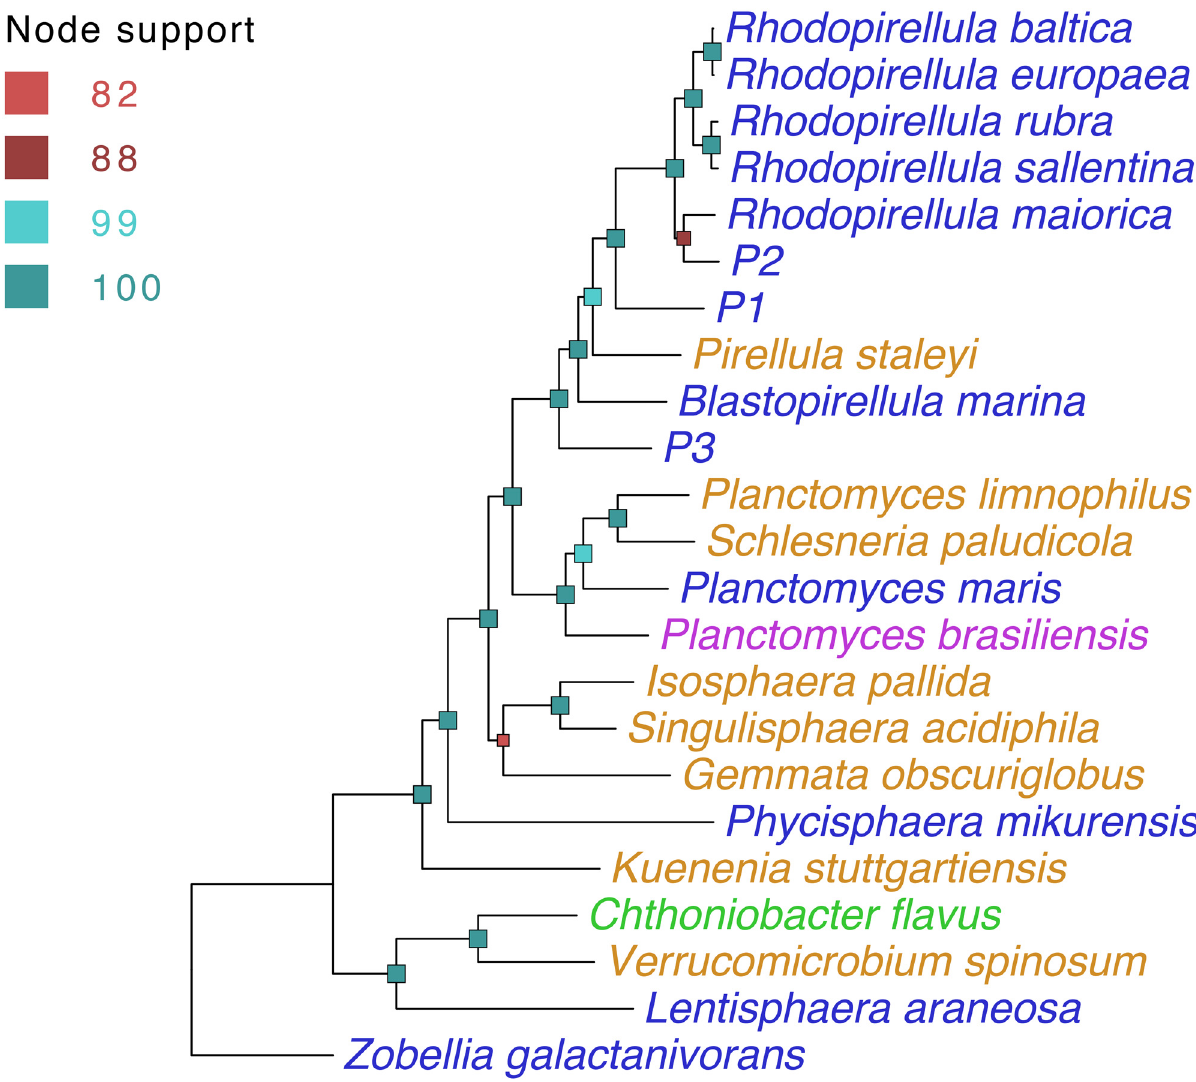
Fig 1. Phylogeny of three novel planctomycetes and related species. The phylogeny shown is based on concatenated protein-coding sequences of 39 highly conserved, single-copy genes (see S1 Table). Consensus maximum likelihood trees from 1000 bootstrap iterations are shown. Internal nodes are color-coded (indicated to the left of each tree) based on bootstrap support values. Taxa are color-coded by the type of habitat from which they were isolated: marine [blue], freshwater [orange], marine/brackish [purple], soil [green].